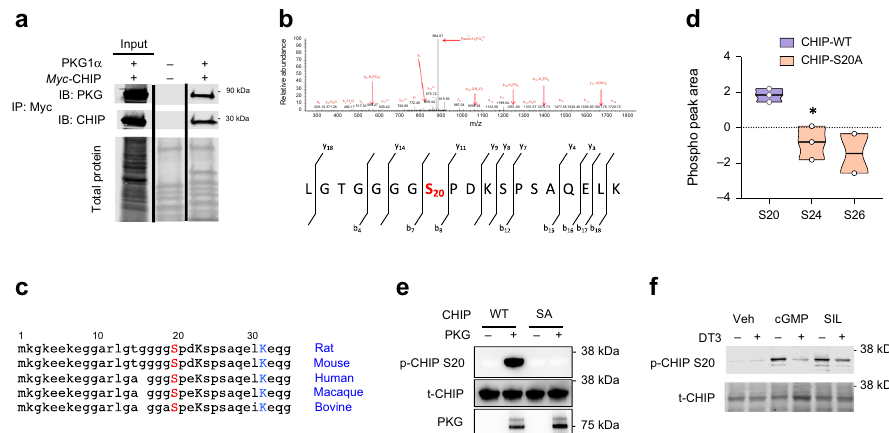
Fig. 2 CHIP is phosphorylated by PKG at Serine 20. a Immunoprecipitation of Myc-tagged CHIP with PKG1 α . Lanes: 1-input, 2 negative control, 3-IP signal after three bead washes. Experiment replicated ×3. b Mass spectroscopy detects increased Chip-S20 (mouse sequence) phosphorylation with acute PKG activation. The lower schematic shows the sequence and fragmentation matching the spectra (above). The M2S spectra has red annotations for the assigned ion fragments, with three fragment ions localizing phosphorylation at S20 (b8 and y11 indicate it occurs on the N-terminal sequence of LGTGGGGS, b7 indicates the sequence LGTGGGG does not contain the site. Study performed with 3 biological replicates. c CHIP peptide sequence from start of N-terminus shows high level of conservation including three serines (S19, S23, S25 for human; S20, S24, S26 for mouse and rat). Lysine 30 (K30 human, K31 mouse) is also nearby, highly conserved, and known to be critical for CHIP-chaperone binding. d Mass Spec detection of serine phosphorylation of recombinant human CHIP peptide fragment containing residues 13 – 30 (Uniprot Q9UNE7). Only S20 phosphorylation is detected with WT CHIP. If S20A mutation is expressed, some reduced phosphorylation is observed at S24 and S26. All biological replicates shown in fi gure, truncated violin plot, median and 25/75%; unpaired t -test, * p = 0.01 vs CHIP-WT. e Recombinant PKG1 α /CHIP assay shows pS20 signal by immunoblot for full length WT but not S20A mutant. Example of three biological replicates. f Phospho S20 antibody detects CHIP phosphorylation at S20 in rat myocytes exposed to cGMP or PDE5A inhibition, and both are blocked by concomitant PKG inhibition with DT3 (1 μ M). Gel repeated ×3, with 3 – 4 biological replicates. Summary analysis in Supplementary Fig. 2a.